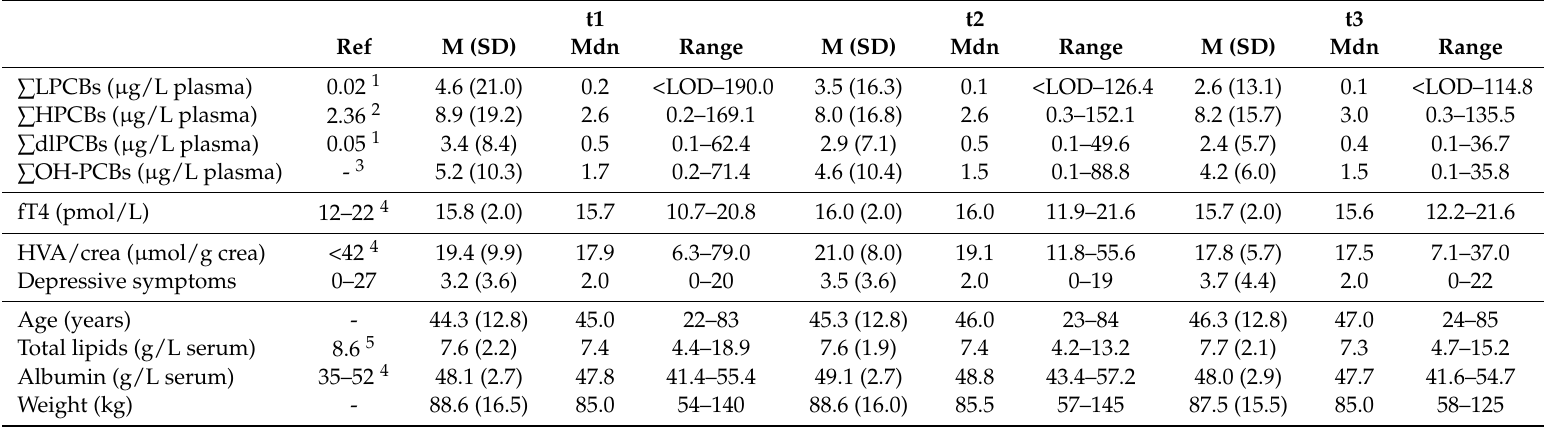
Table 1. Description of the study population (N =